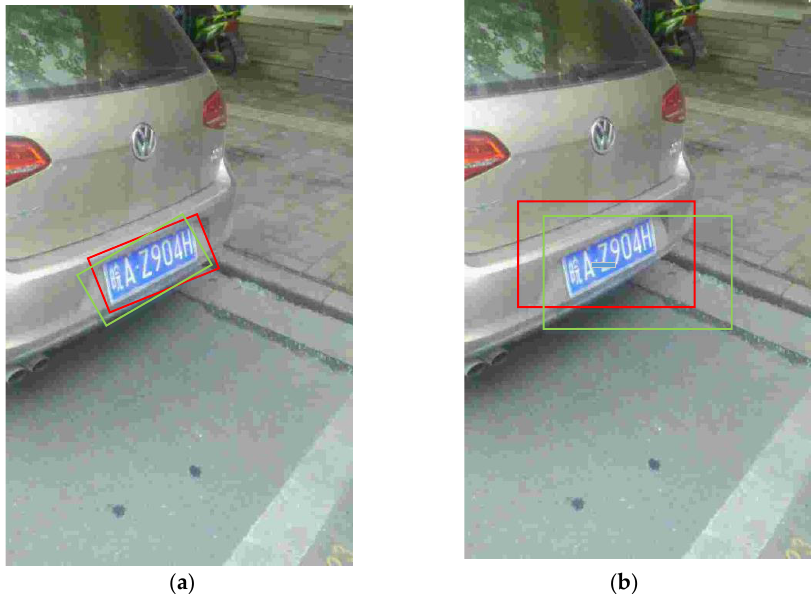
Figure 5. License plate boundary box improvements; ( a ) End-to-end network; ( b ) Contemporary networks.